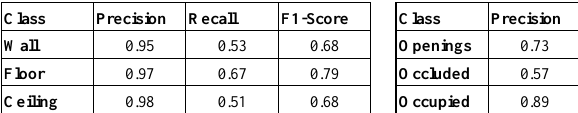
Table 2. Accuracy results of 2 nd iteration (section 3.5), left: permanent structure detection results, right: opening detection results. For opening detection because we do not have total number of points in openings and gaps (there is hole in the data), we just show the correctness (precision) of the detected results and not completeness (recall).